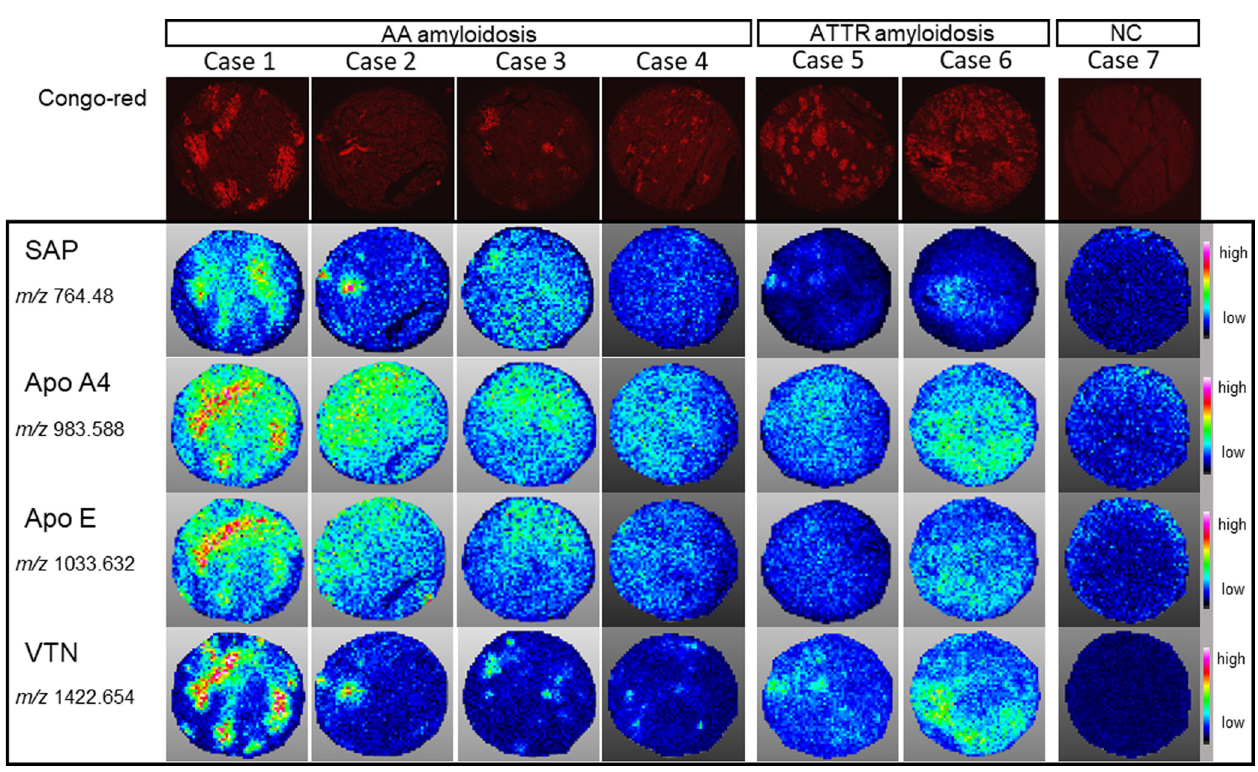
Fig 4. Ion images of co-deposited proteins in cardiac tissue of patients with AA and ATTR amyloidosis. Congo red staining (upper panels) and ion images of serum amyloid A (SAP) ( m/z 764.48), apolipoprotein A4 (Apo A4) ( m/z 983.588), apolipoprotein E (Apo E) ( m/z 1033.632), and vitronectin (VTN) ( m/z 1422.654) (lower panels). The intensity range is given for each ion image on the right-hand side. The core diameter of the histological sections was 2 mm.